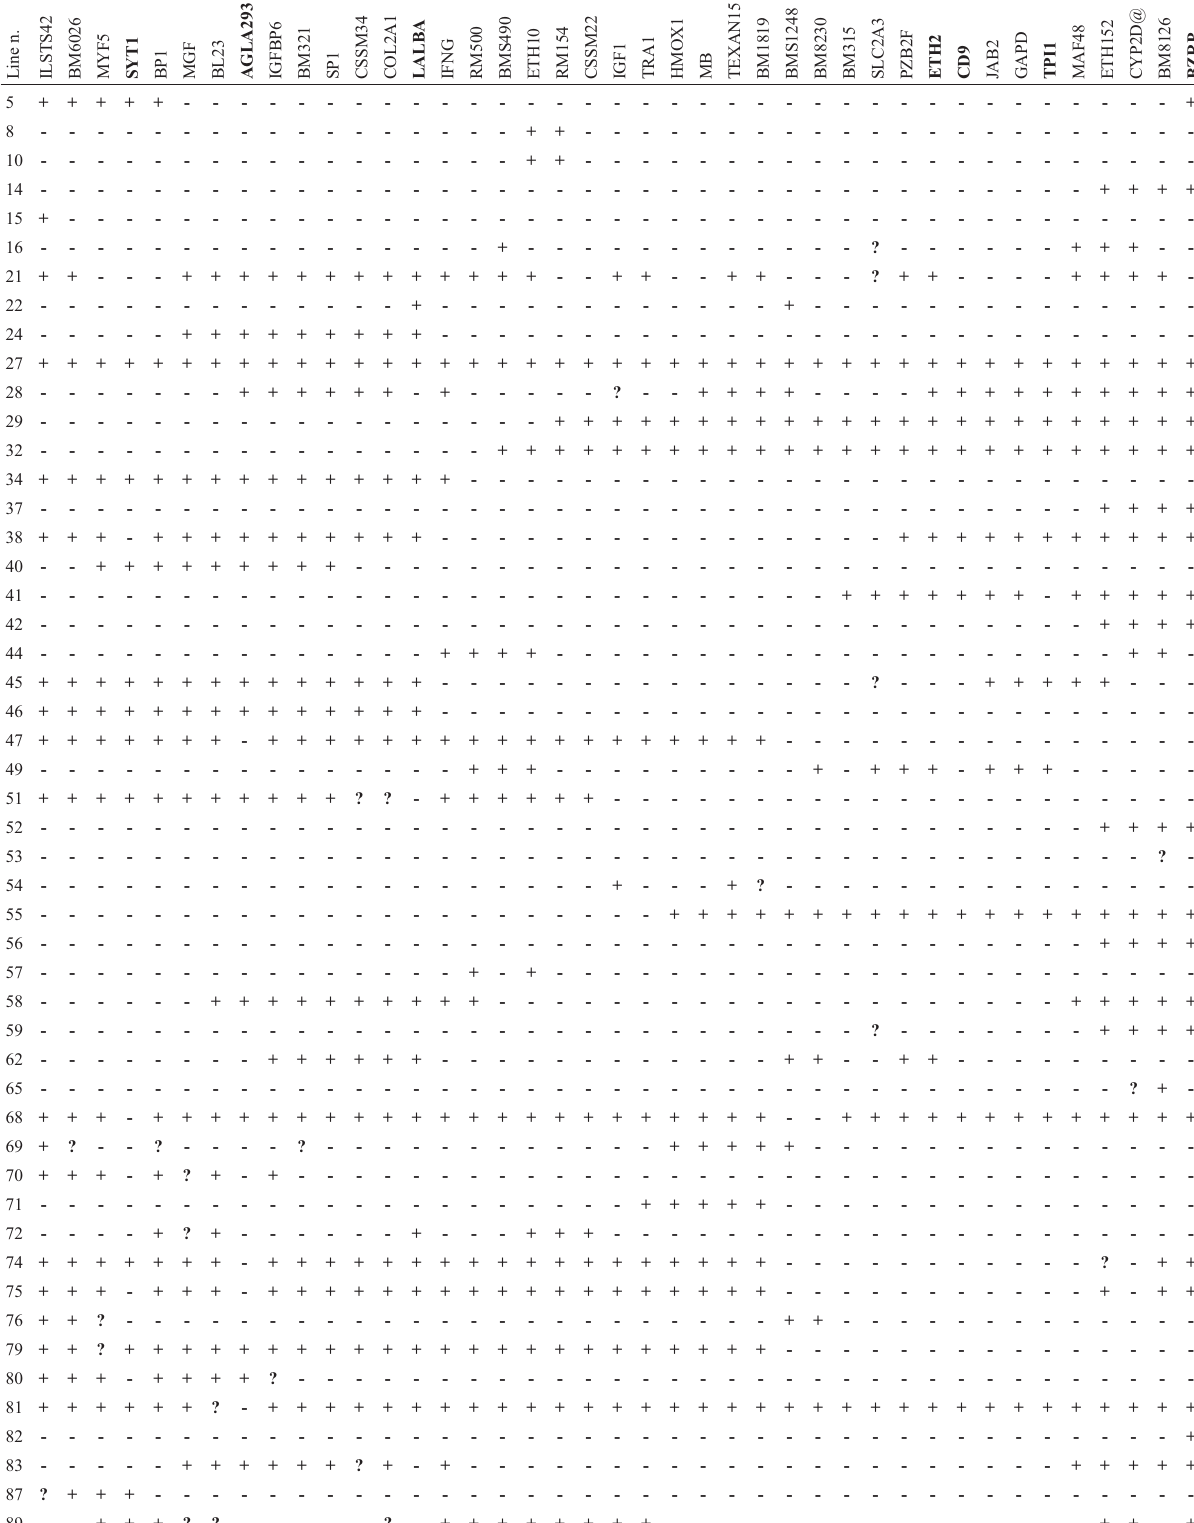
Table 3 - Scoring data for the informative cell lines for the markers used in the construction of the RH map of BTA5. Loci are placed according to their mostlikelyorderdeterminedbymaximumlikelihoodmethods.Hybridcelllinesforwhichallmarkerswereabsentarenotshown.Boldfacemarkerswere scored by Barendse et al .